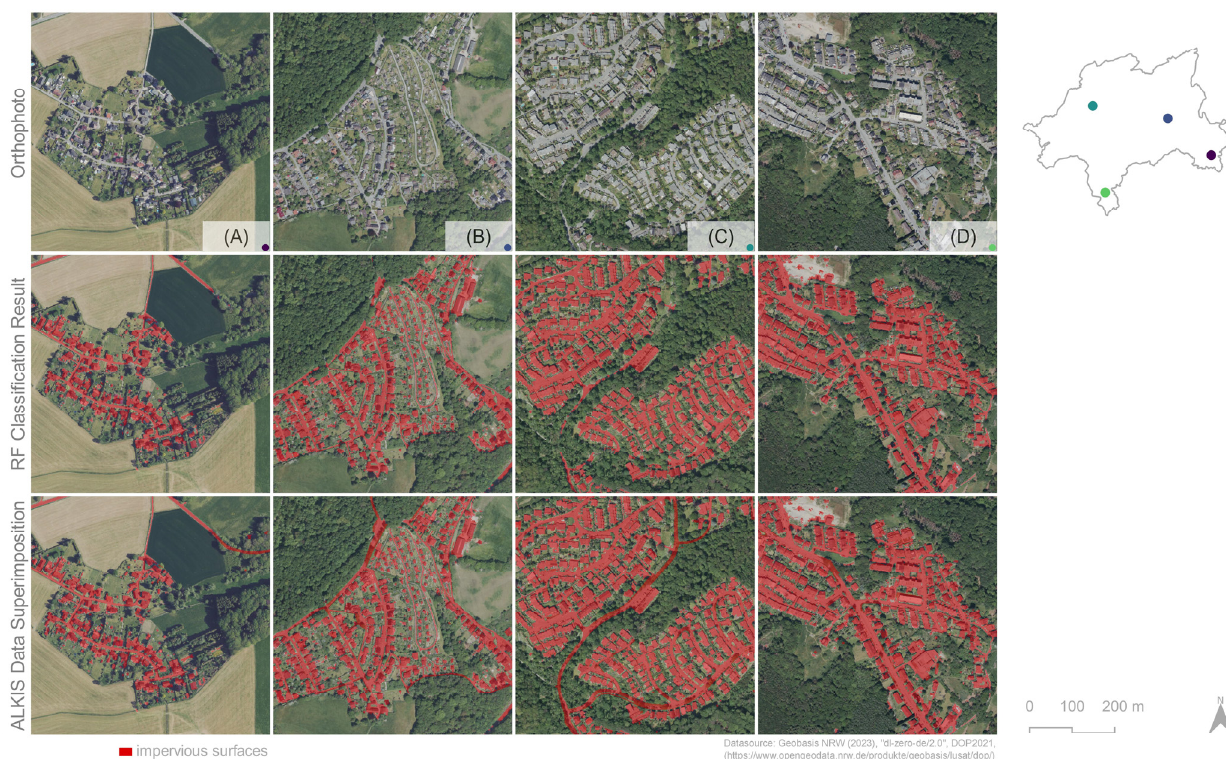
Figure 9. Comparison of RF classification results and data superimposition results in suburban to semi-urban settlement areas: isolated settlement areas (A), allotments between settlement areas (B), residential areas (C,D).